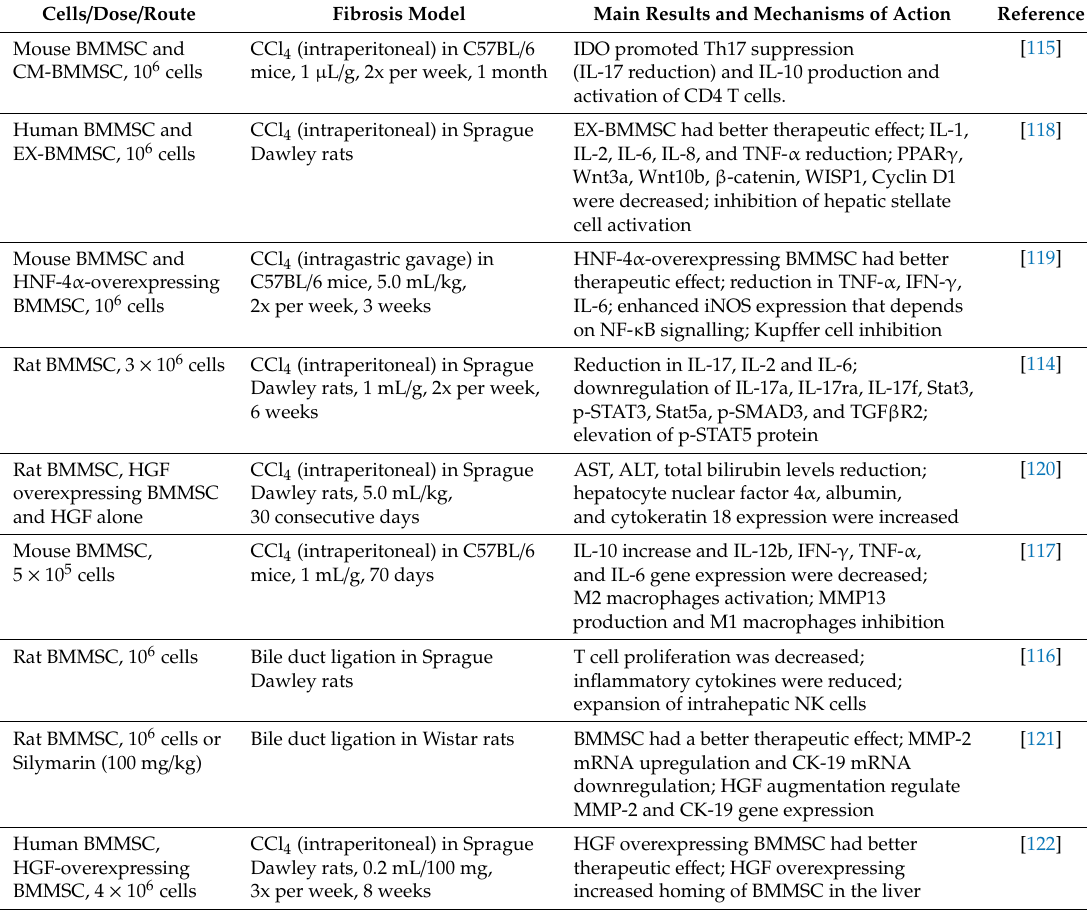
Table 4. Experimental liver fibrosis and bone marrow mesenchymal stem cells. Cells / Dose / Route Main Results and Mechanisms of